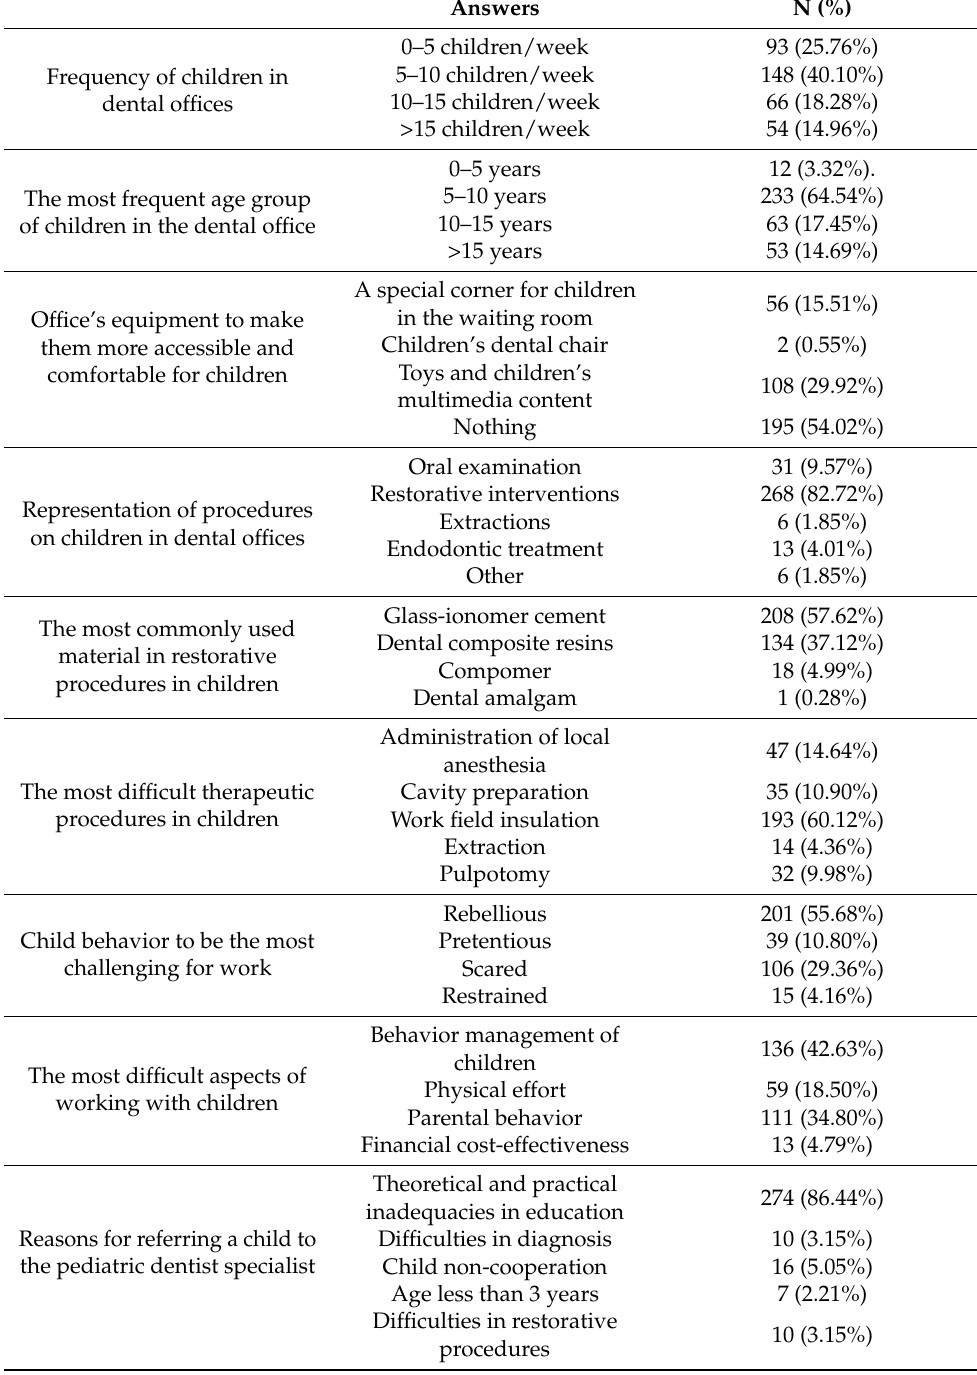
Table 1. Survey of respondents considering children in their dental